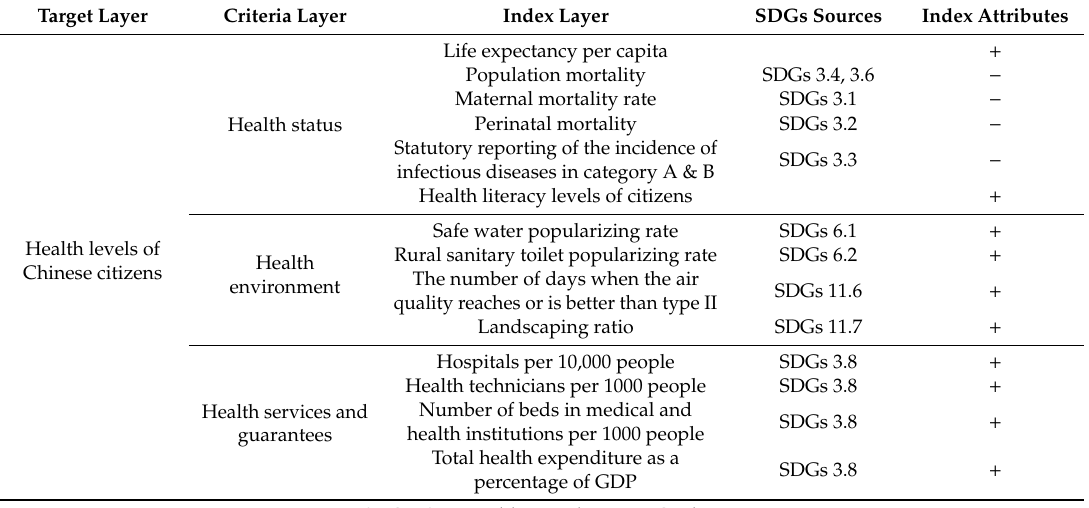
Table 1. The index system used for a comprehensive evaluation of Chinese citizens’ health